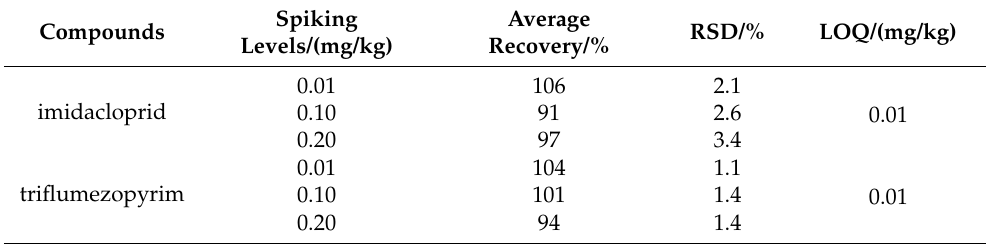
Table 2. Method validation